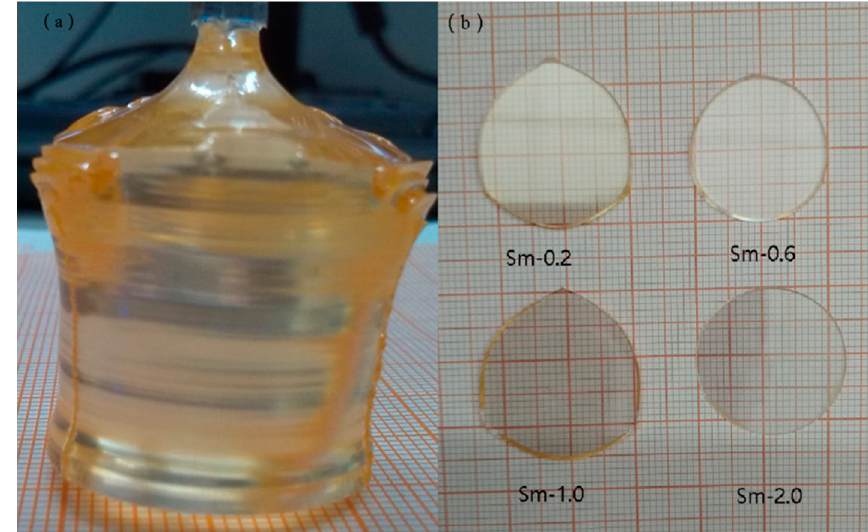
Figure 1. ( a ) As-grown and homogeneous single crystals orange 1.0 mol.% Sm 3+ -doped lithium niobate (LN) with the diameter of 25 mm and the length of 35 mm. ( b ) The double-side polished sample wafers, with Sm 3+ -doped concentration from 0.2 mol.% to 2.0 mol.%, were marked as Sm-0.2, Sm-0.6, Sm-1.0, and Sm-2.0, respectively.